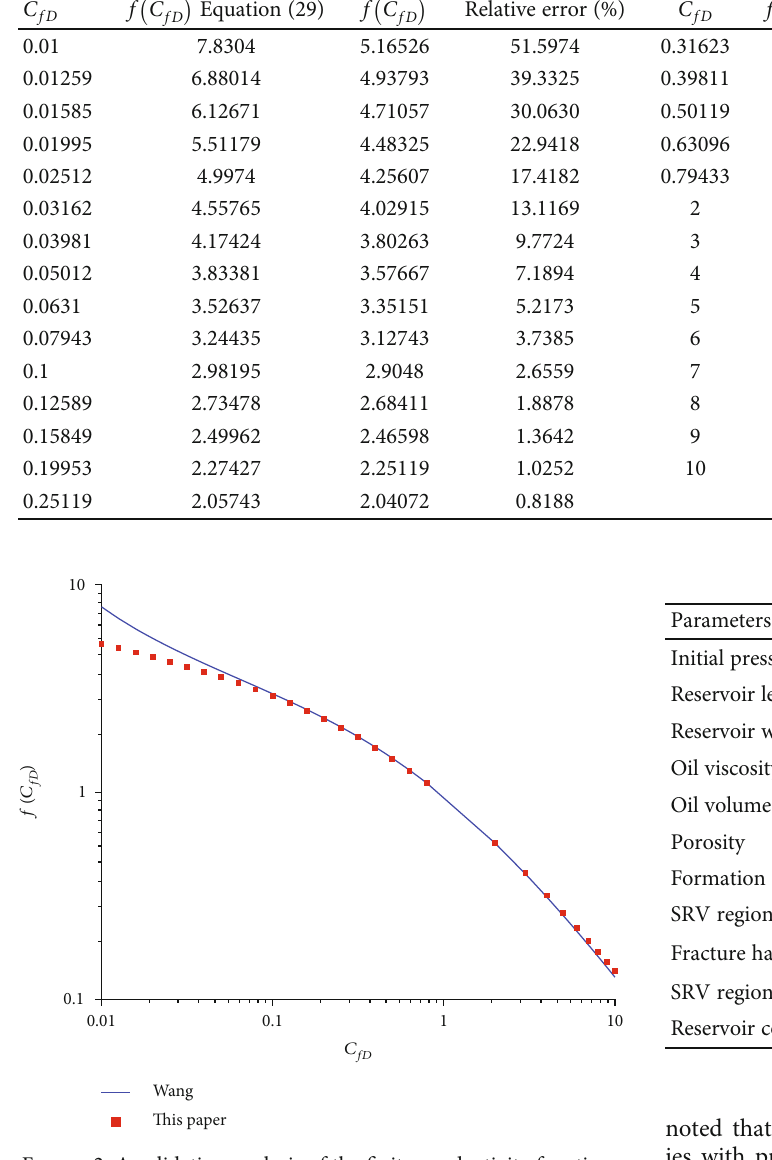
Figure 2: A validation analysis of the fi nite conductivity function.